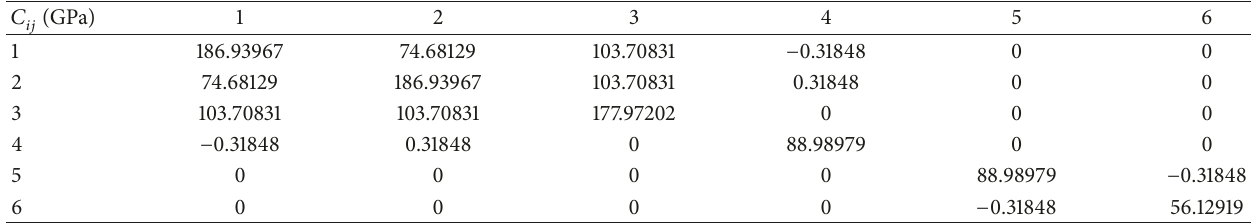
Table 3: Elastic stiffness matrix of quartz